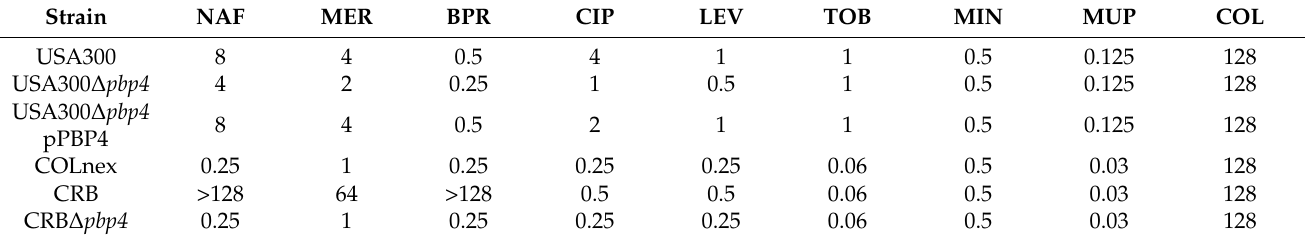
Table 1. Minimum inhibitory concentration testing ( µ g mL − 1